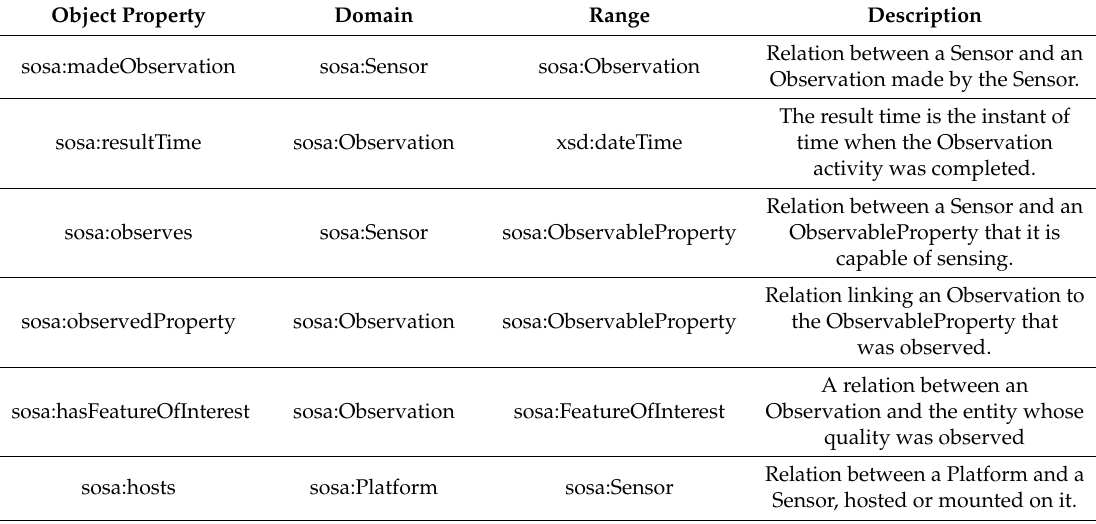
Table 2. The object properties, domain, range, and the description of main object